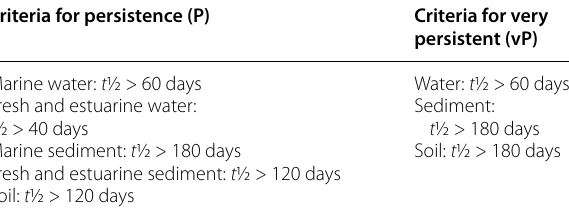
Table 1 Criteria for the classification as P or vP [23] Criteria for persistence (P) Criteria for very